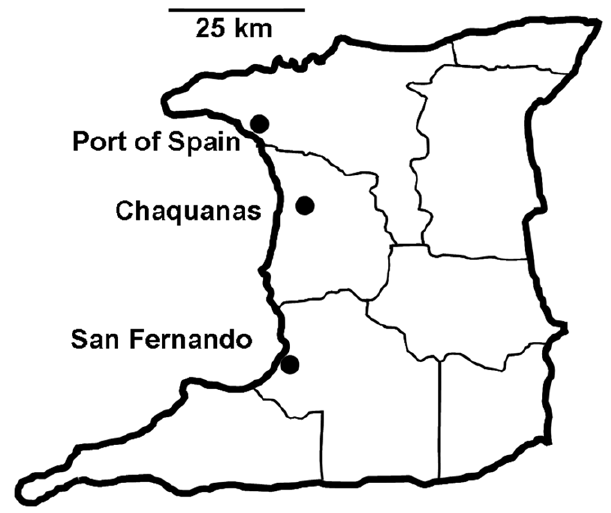
Figure 2. Collection sites were located along Uriah Butler Highway in the Charlieville neighborhood of Chagaunas, Trinidad, West Indies. This is the major north-south highway from Port of Spain to San Fernando.